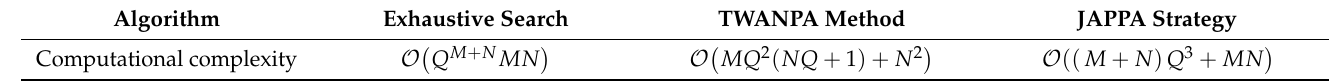
Table 1. Computational complexity comparison.